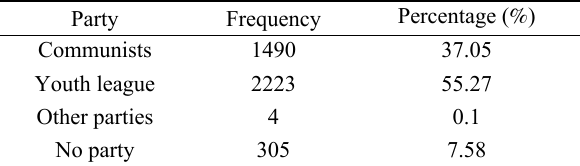
Table 4 Descriptive analysis of political status factor.